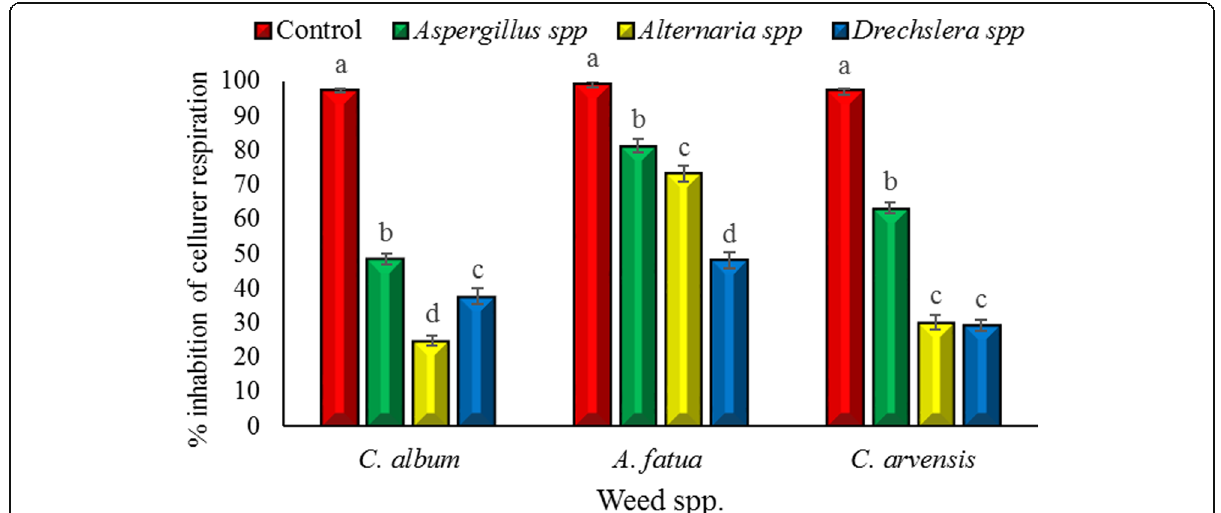
Fig. 3 Effect of cultural filtrates of endophytic fungi on the cellular respiration of C. album , A. fatua , and C. arvensis . Different letters show significant differences of treatments in each weed separately